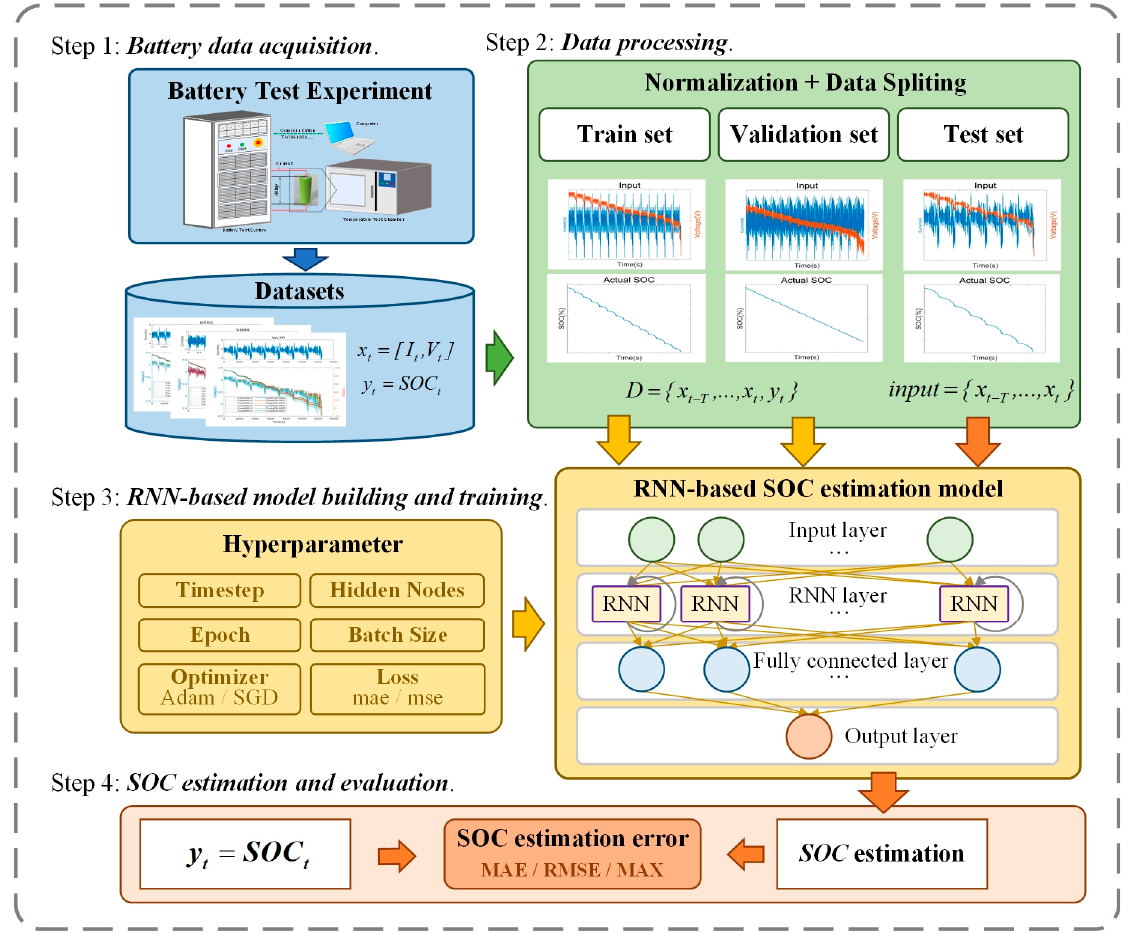
Figure 1. The RNN-based SOC estimation framework .